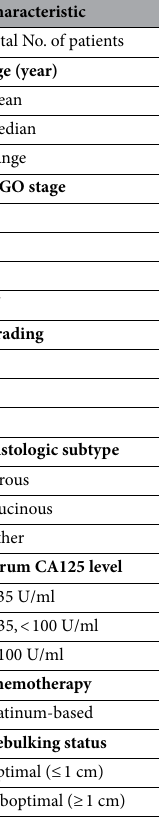
Table 1. Clinicopathological characteristics of the EOC patients.